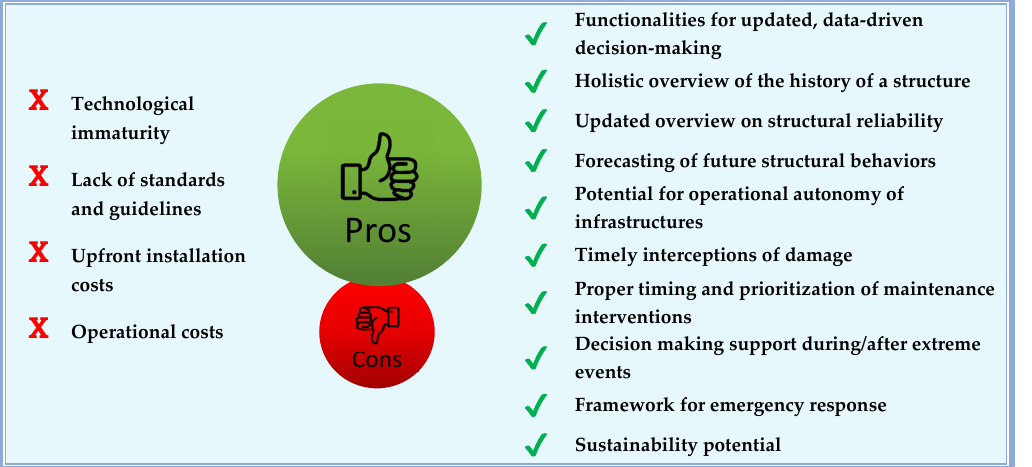
Figure 4. Pros and cons of a Digital Twin implementation in a civil engineering system from an infrastructure manager perspective.